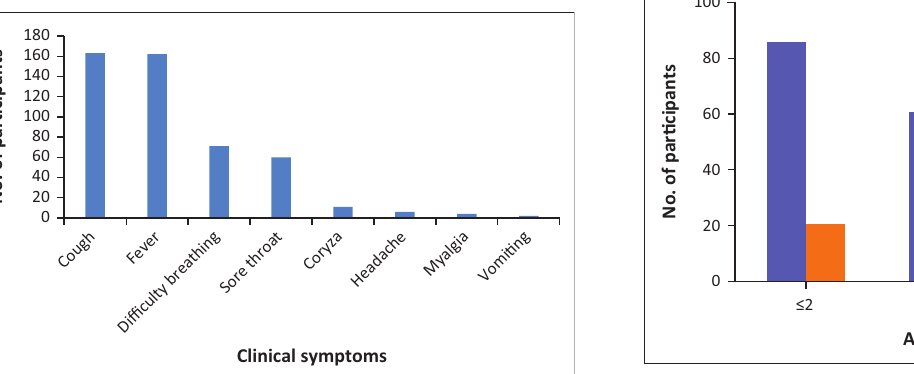
FIGURE 3: Occurrence of enterovirus D68 in the different age groups of ARIs investigated.